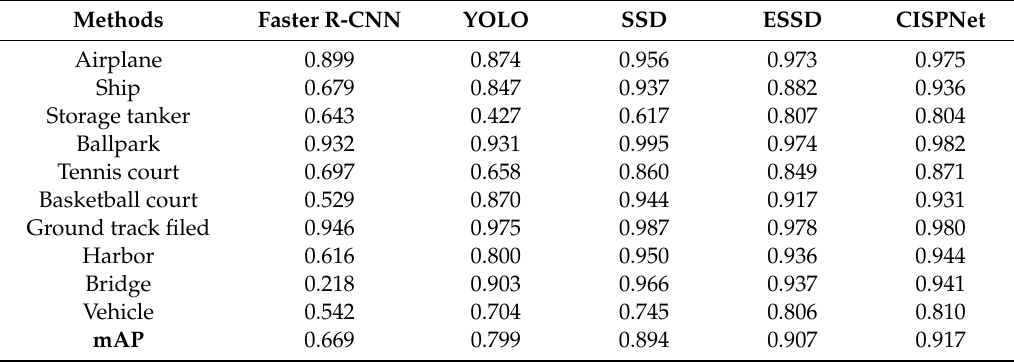
Table 5. Comparison of different detection methods based on NWPU VHR-10 benchmarks.